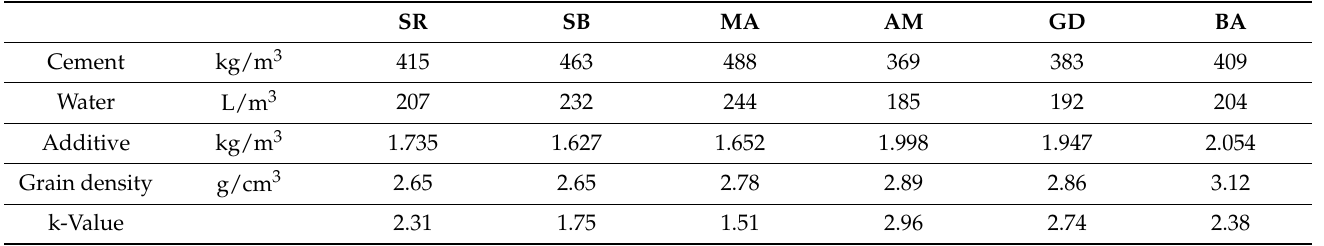
Table 1. Base formulations for concrete of strength class C 25/30 with potential primary m-sand substitutes.